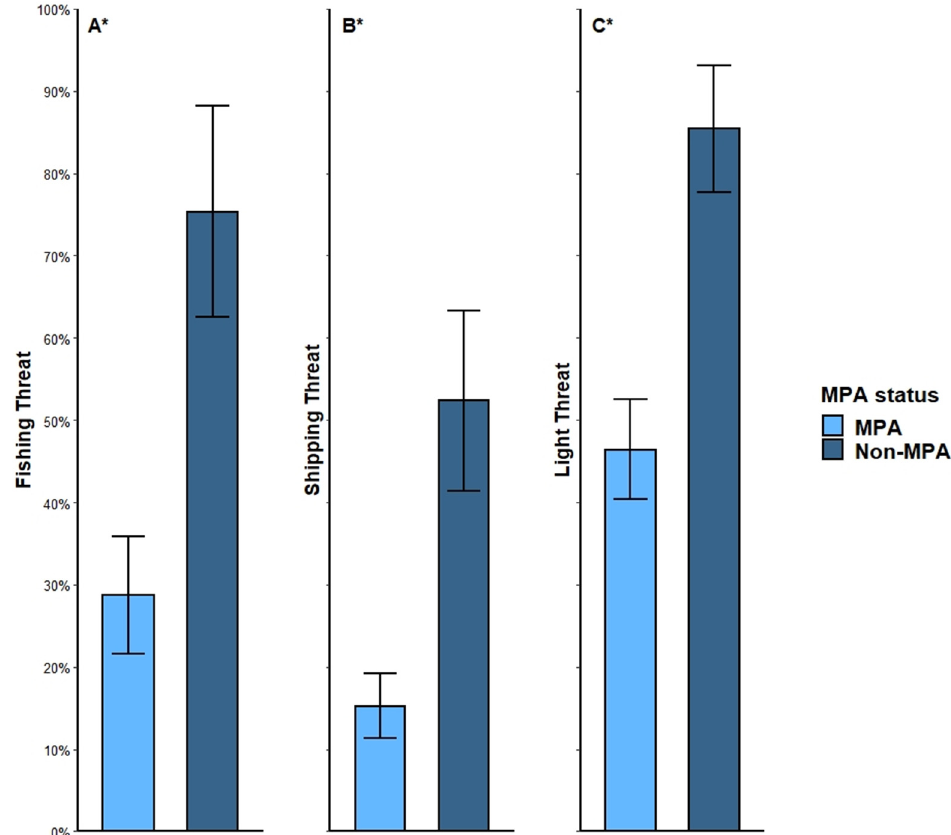
Figure 8. Average percentage of days a “high” threat of three categories (Fishing, Shipping, and Light Pollution) was encountered for “MPA” and “Non-MPA” turtles. “High” threats were classified by threat scores above the median value for the given threat. “MPA” and “non-MPA” classification were calculated by the mean percentage of time an individual turtle was in or out of an MPA boundary. “Non-MPA” turtles were significantly more likely to encounter a “high” threat than “MPA” individuals for all three tested threat variables ( Fishing ( A )—T 38 = − 3.399, p = 0.002, Shipping ( B )—T 38 = − 3.191, p = 0.007, Light Pollution ( C )—T 38 = − 3.7005, p = < 0.001). Error bars represent standard error. Asterisks (*) next to each embedded figure letter denote a significant result.